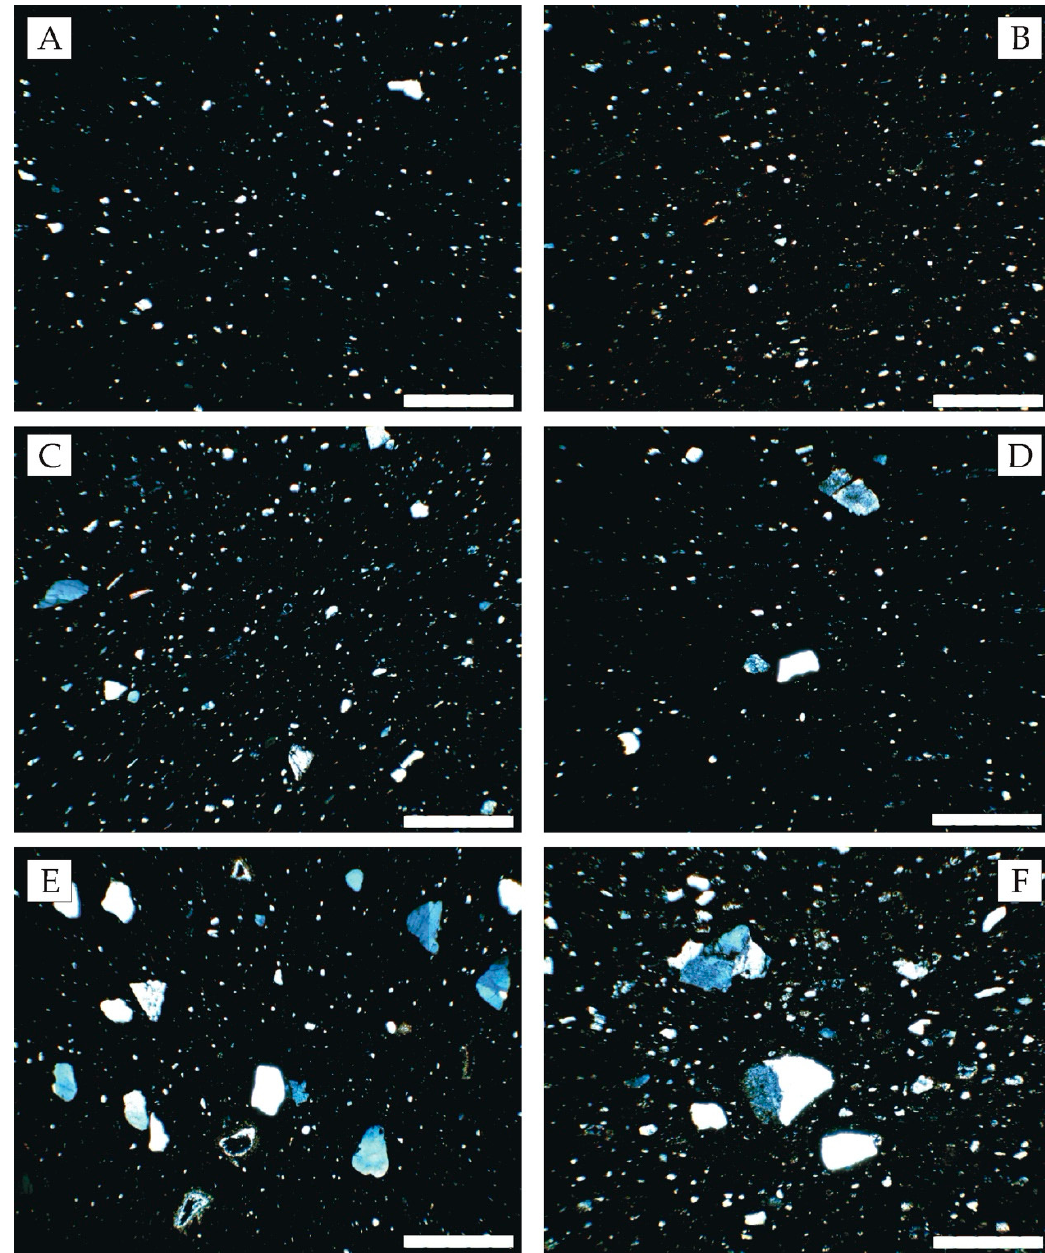
Figure 6. ( A ) MPP-1: sample M179-157; ( B ) MPP-1: sample M179-234; ( C ) MPP-2: sample M179-171; ( D ) MPP-2: sample M179-161; ( E ) MPP-3: sample M179-160; ( F ) MPP-3: sample M179-158 (crossed polar; scale bar = 0.5 mm) .